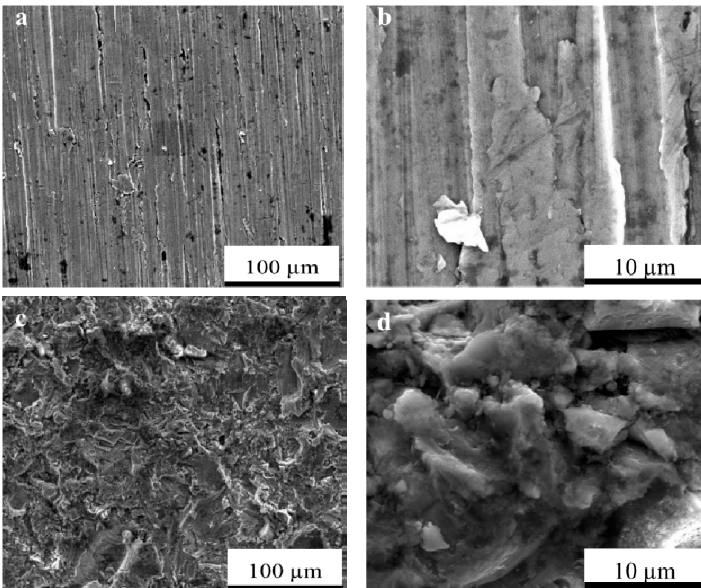
Figure 7. A SEM micrograph of Ti samples: Untreated samples ( a ) 1000× and ( b ) 10000× magnifi- cation; sandblasted samples by aluminum oxide ( c ) 1000× and ( d ) 10000× magnification [102] (re- produced with permission number: 5071110018393, AIP Publishing).